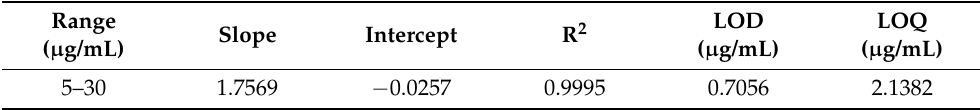
Table 1. Coefficient of determination (R 2 ) of the calibration curves, limit of detection (LOD), and limit of quantification (LOQ) of the HPLC method for ketoprofen.